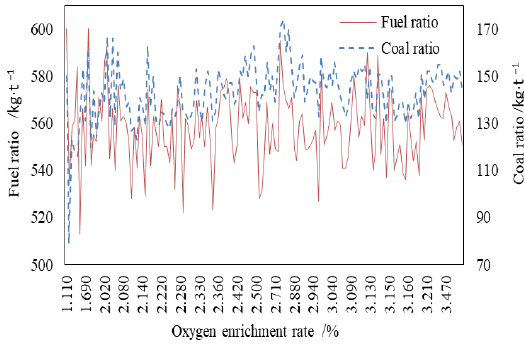
Figure 5. Results of the industrial test.